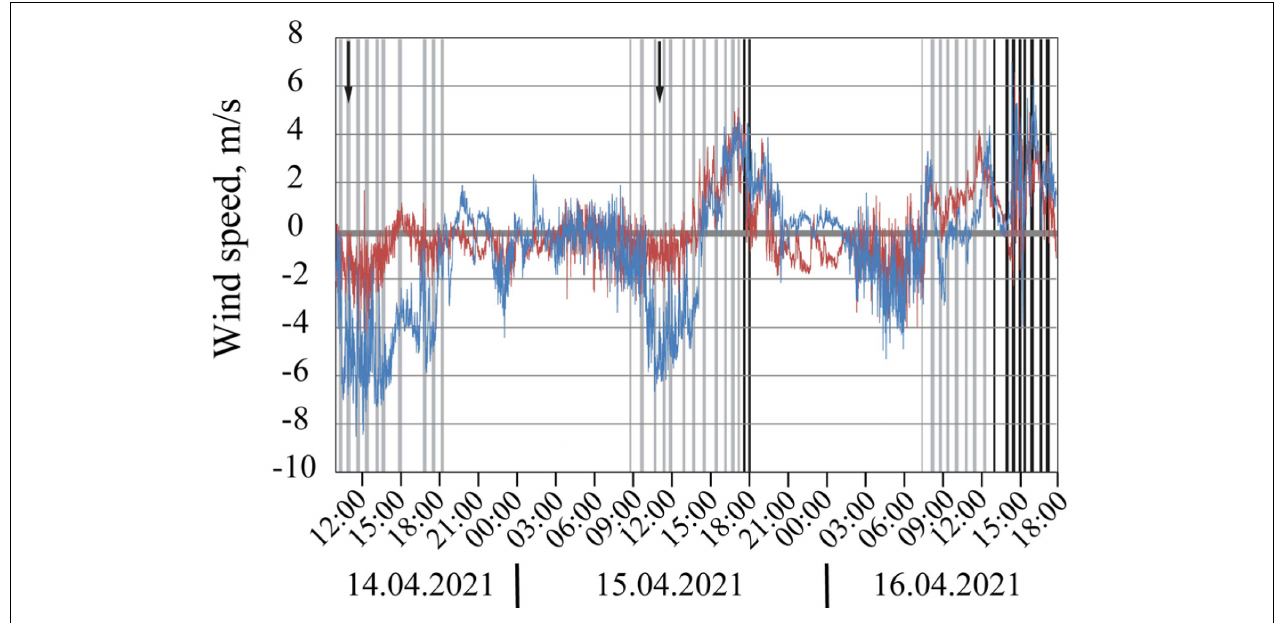
FIGURE 2 | Eastward (blue) and northward (red) components of wind speed on 14–16 August 2021 at the study area. Gray and black bands indicate periods of aerial observations of the Bzyb plume, gray band mark northward spreading of the plume, black bands mark southward spreading of the plume. Two black arrows indicate times of two satellite images of the study area acquired during the period of field